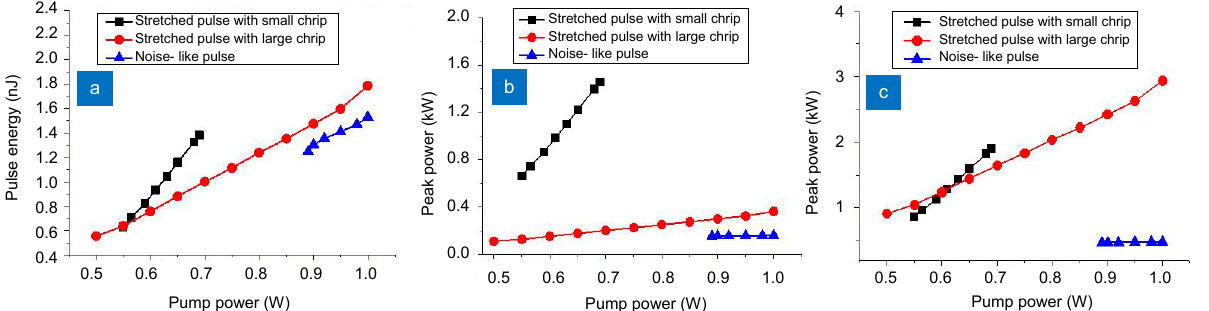
Fig. 6 | ( a ) Single pulse energy as a function of pump power. ( b ) Peak power as a function of pump power before compression (at point a in Fig. 1). ( c ) Peak power as a function of pump power after compression (at point c in Fig. 1).